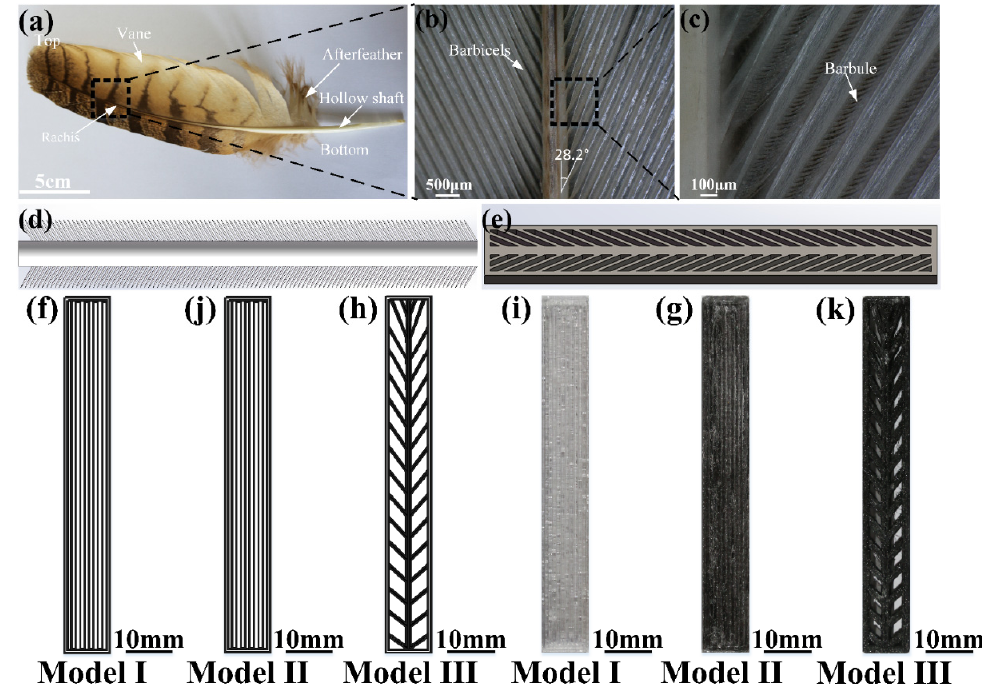
Figure 2. ( a ) Morphology, ( b ) barbicels, ( c ) barbules of eagle-owl feather, ( d ) bionic simplified model and ( e ) bionic structure model of feather, 3D printing path of ( f ) Model I, ( j ) Model II and ( h ) Model III and 3D printing sample of ( i ) Model I, ( g ) Model II and ( k ) Model III. Table 1. Three types of print model parameters.